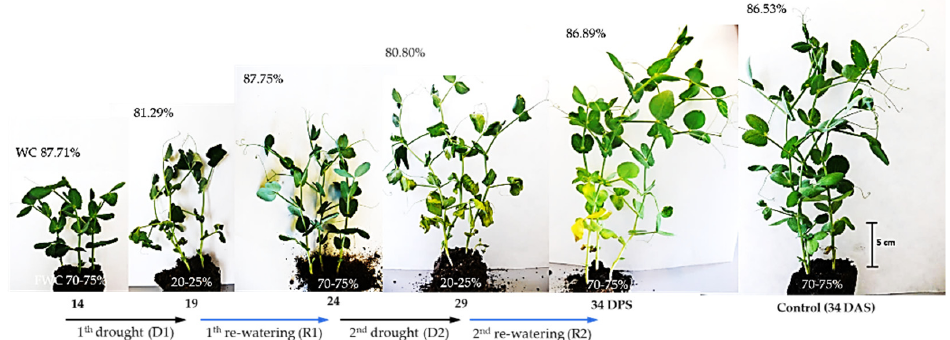
Figure 1. Plants of pea ( Pisum sativum L., cv. Hubal) during repeated short-term soil drought during 14–19 DAS and 24–29 DAS, and subsequent re-watering (19–24 and 29–34 DAS). Control plants at 34 DAS are shown on the right. The values in the top left-hand corner of each picture indicate the water content (WC) in the shoot, whereas the bottom indicates soil water capacity (in %).